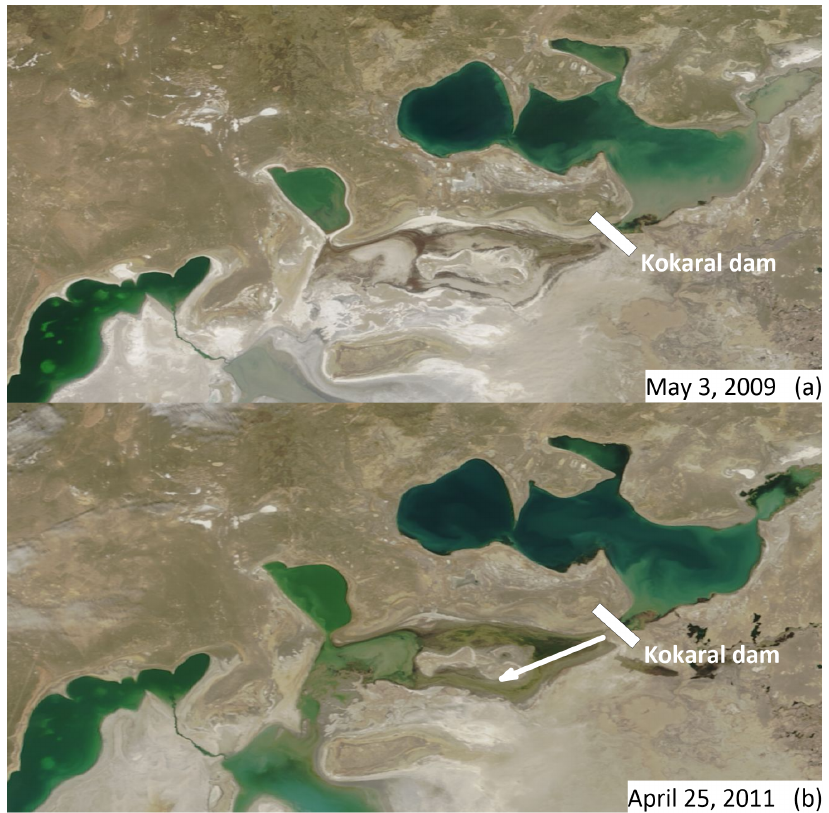
Figure 8. Satellite images of the Small Aral Sea and its outflow area seen from MODIS Terra on 3 May 2009 ( a ) and 25 April 2011 ( b ) taken from https://worldview.earthdata.nasa.gov, accessed on 8 April